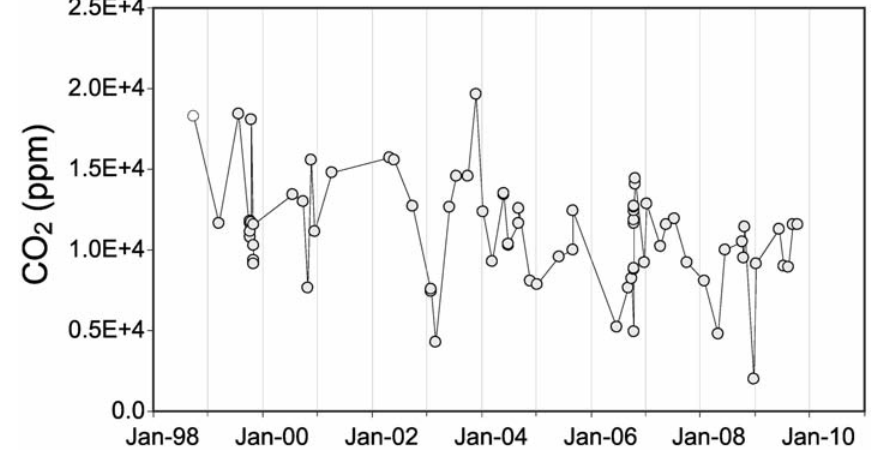
Figure 3. Chronogram of the CO